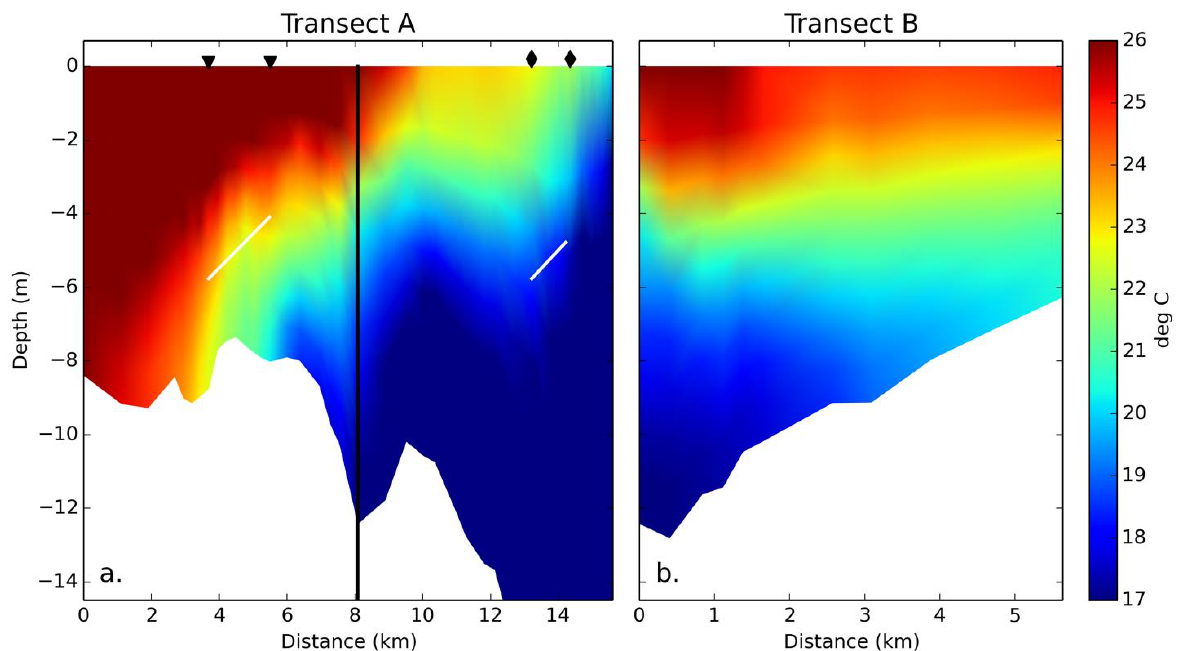
Figure 3. Model temperature along transect lines ( a ) A and ( b ) B (shown in Figure 1) on 2 August 2018. Triangle and diamond markers denote the transects along which temperature observations were collected and the estimated interface slopes from Figure 2 are reproduced here. The black line indicates the point at which transect B intersects with transect A.